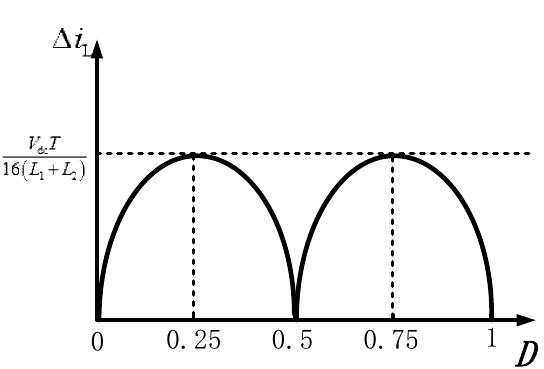
Figure 8. The relation between the duty cycle D and the output inductor current ripple Δ i L .